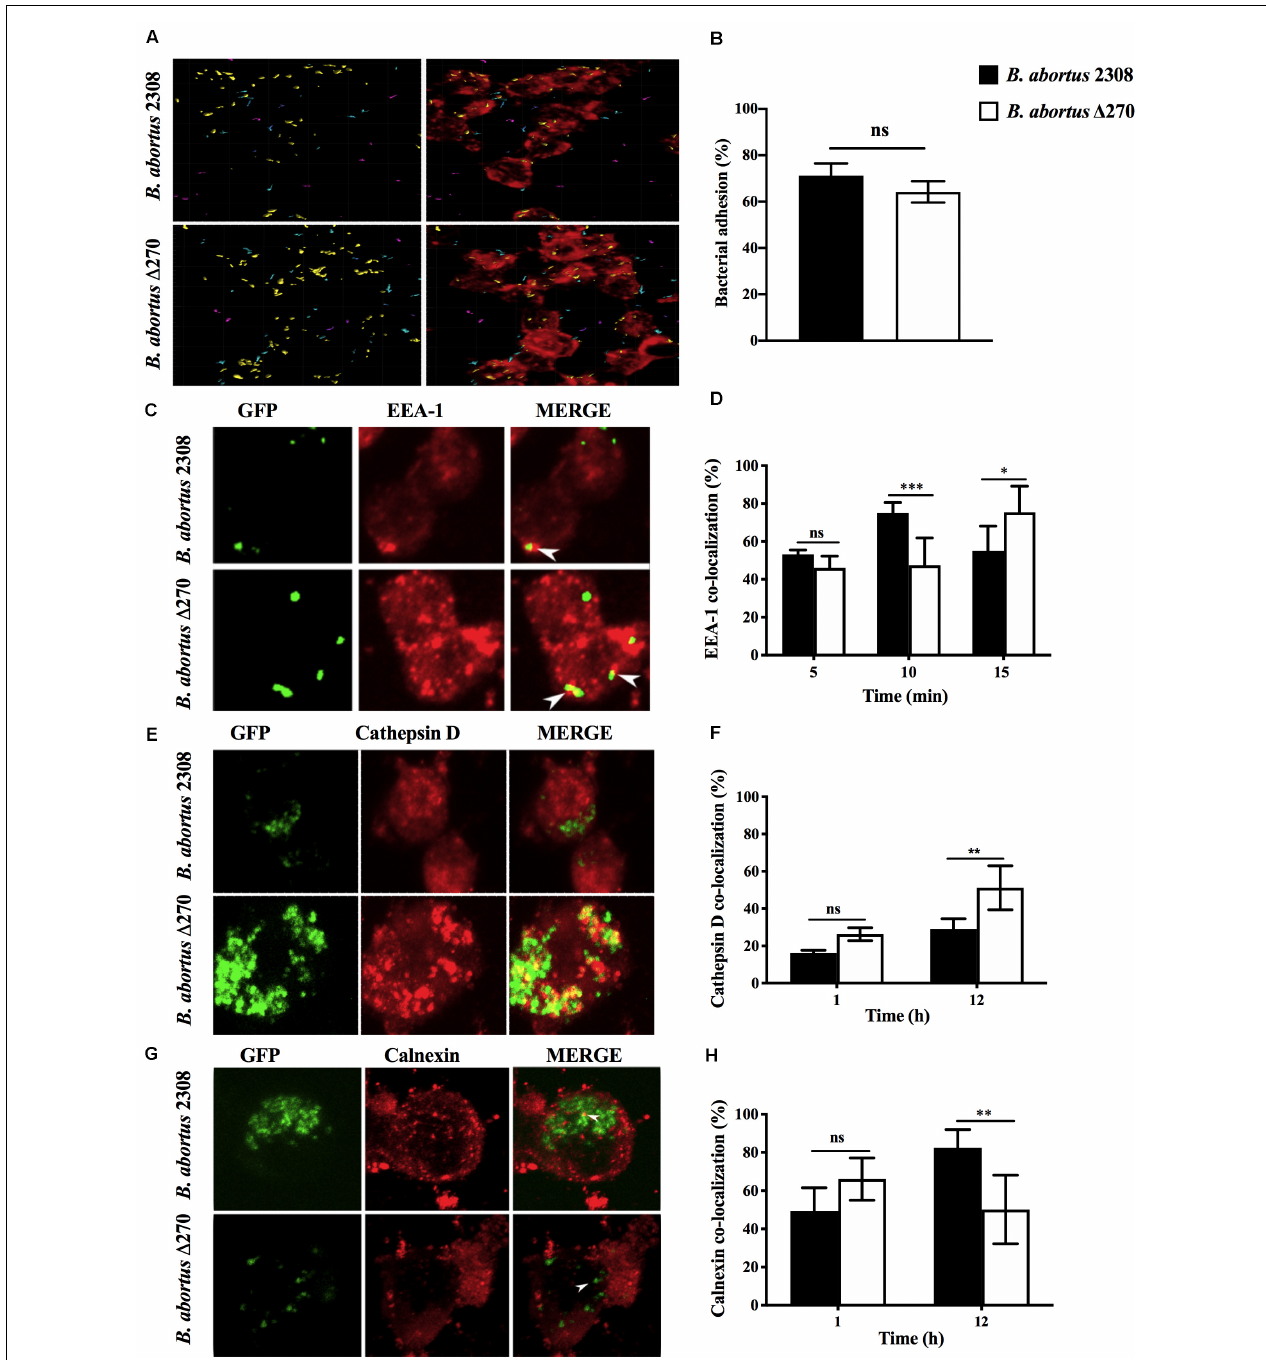
FIGURE 3 | Adhesion and intracellular trafficking of B. abortus strains in RAW267.4 macrophages. (A) Macrophages were treated with cytochalasin D (0.5 mg/ml) and infected with the B. abortus 2308 and B. abortus (cid:49) 270 strains for 30 min. Image shows the proximity of B. abortus strains with the RAW264.7 macrophages, where cyan represents bacteria with a proximity less than 5 mm from macrophages, purple represents bacteria with a proximity greater than 5 mm distance from macrophages, and yellow represents bacteria adhered to macrophages. (B) Adherence is expressed by the percentages of bacteria (yellow) adhered to RAW264.7 macrophages. (C,E,G) are representative of confocal images showing the co-localization of B. abortus -GFP strains with EEA1 at 5, 10, and 15 min pi, cathepsin D at 1 and 12 h pi and calnexin at 1 and 12 h pi. (D,F,H) show the percentages of the co-localization of B. abortus -GFP strains with EEA1 at 5, 10, and 15 min pi; cathepsin D at 1 and 12 h pi, and calnexin at 1 and 12 h pi. Results are expressed as the mean ± standard deviation. Values of P < 0.05 were considered statistically significant, where ns: non-significant differences and *, **, and *** denote values of P < 0.05, P < 0.01, and P < 0.001, respectively. All assays were performed in